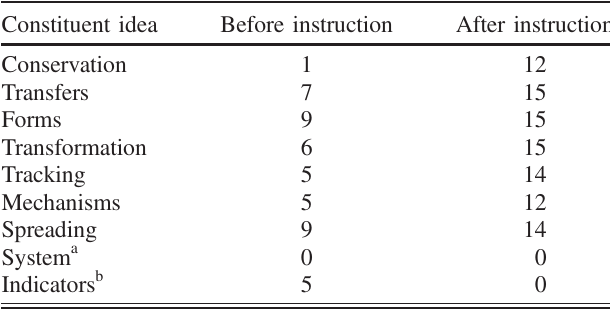
TABLE VII. Class facility with NGSS-aligned energy diagrams ( N ¼ 15